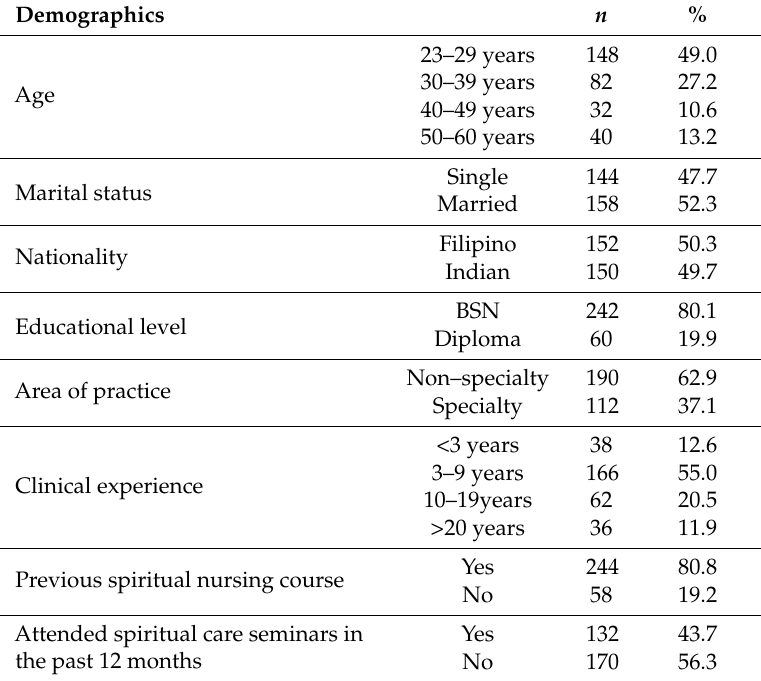
Table 1. Demographic characteristics of the respondents ( n = 302).